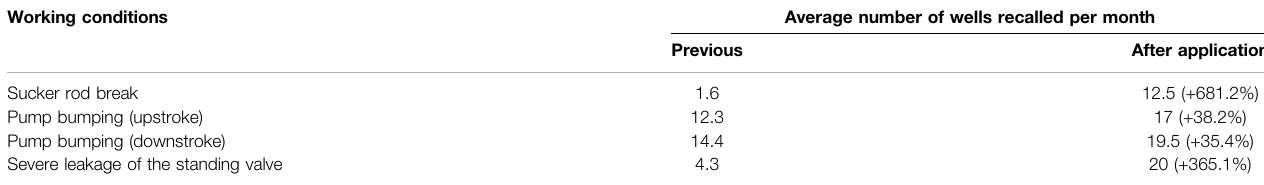
TABLE 10 | Comparison of the monthly average number of wells recalled under severe working